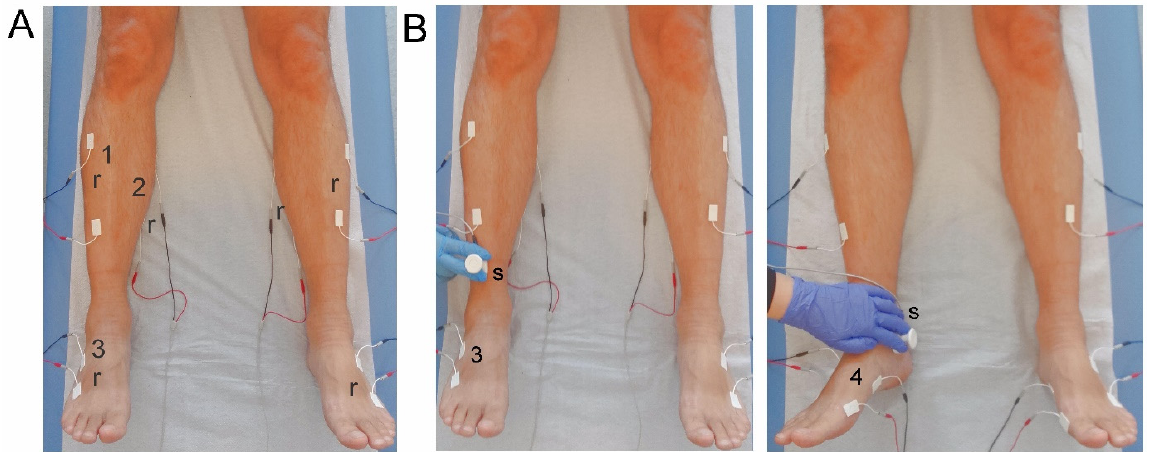
Figure 2. Photographs showing principles of neurophysiological studies in healthy volunteers and iSCI patients. ( A ) Distribution of surface electrodes in the anterior aspect of the human body for bilateral electromyographical recordings (r) from lower extremity muscles (1—tibialis anterior muscle, 2—medial gastrocnemius muscle, 3—extensor digitorum brevis muscle). ( B ) Sites of bipolar stimulating electrode (s) application for electrical stimulation of peroneal (left side) and tibial (right side) nerves at the ankle during electroneuronographic recordings of evoked M-wave potentials from extensor digitorum brevis (3), and abductor hallucis longus (4) muscles.